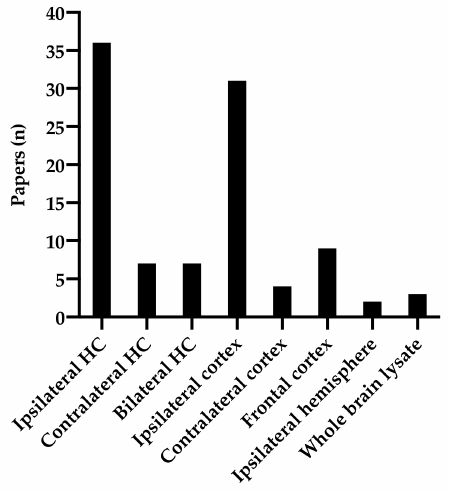
Figure 2. Anatomical regions analyzed in the reviewed